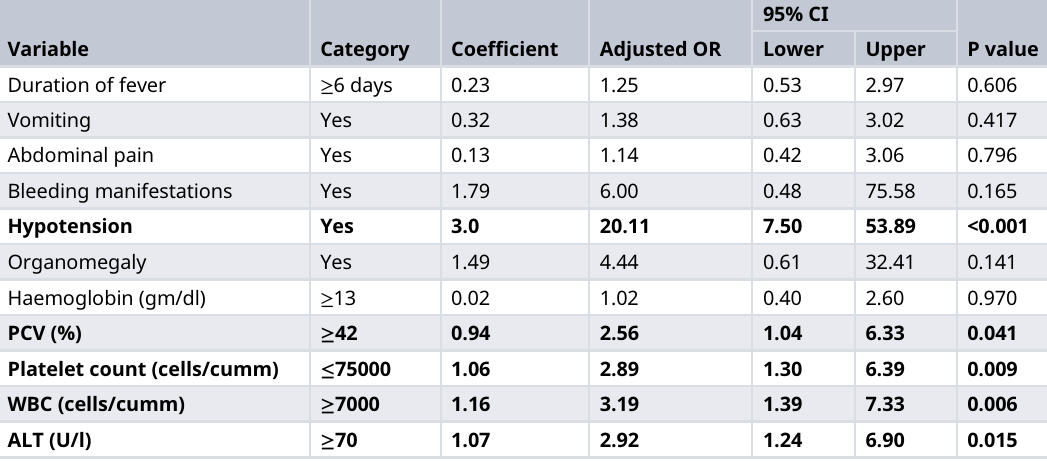
Table 2. Binary logistic regression of variables with P value